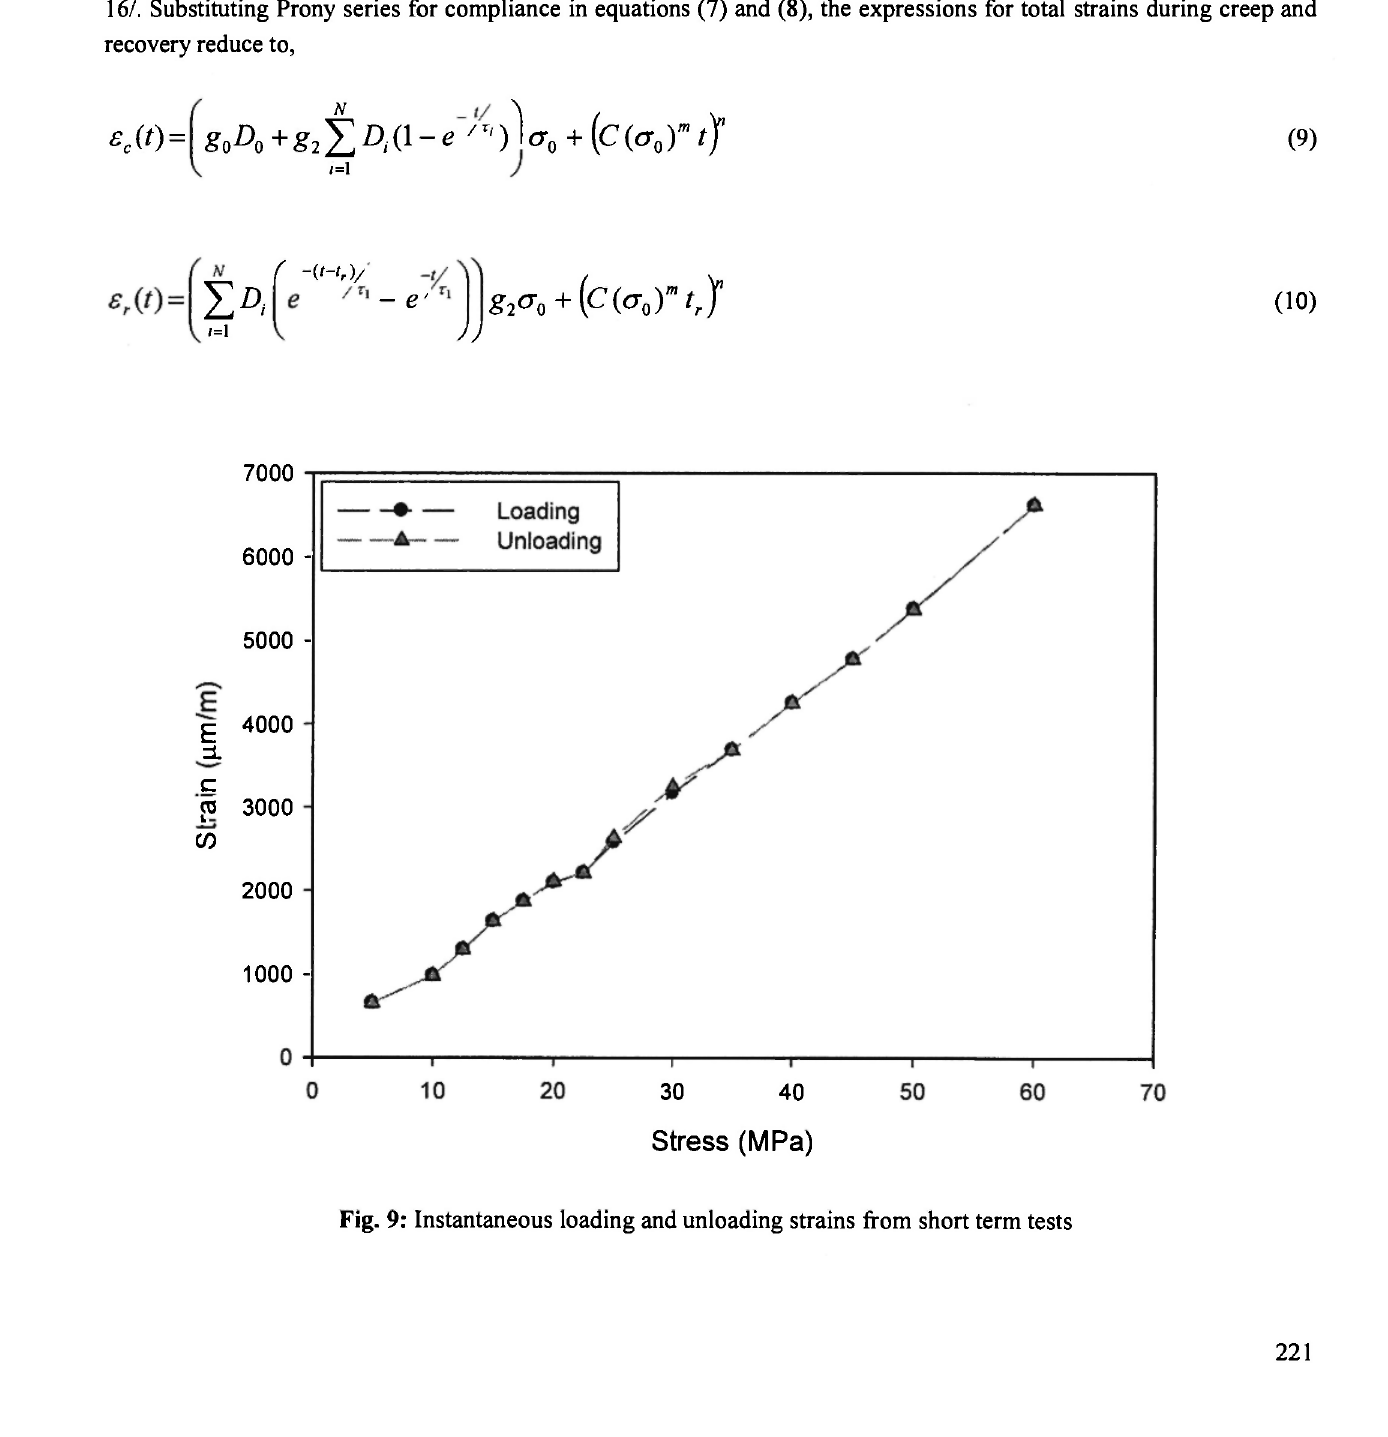
Fig. 9: Instantaneous loading and unloading strains from short term